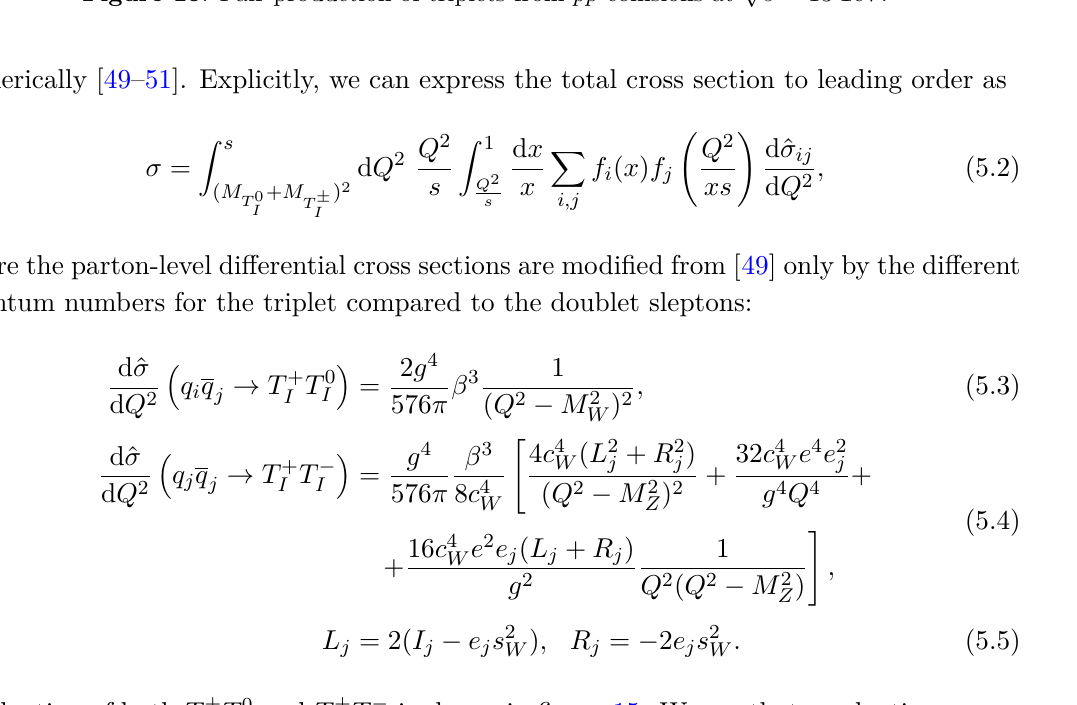
Figure 15 . Pair production of triplets from pp collisions at